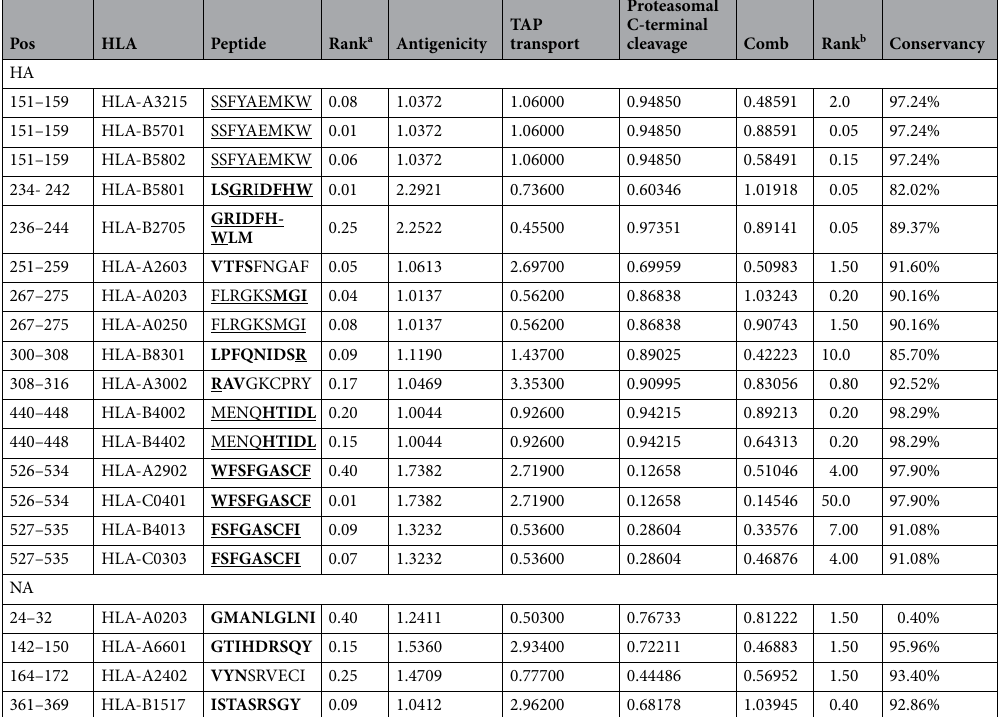
Table 2. CLT epitopes prediction by NetMHC4 server. HA and NA epitopes were selected based on MHC-I HLAs binding affinity (nM), %rank and antigenicity rate. TAP transport/Proteasomal C-terminal cleavage potential selected epitopes were evaluated and degree of conservation was considered for all selected epitopes. Overlapped CLT epitopes are shown in underlined characters as well as CLT epitopes overlapped with HTL epitopes are shown in bold characters. a Rank Threshold for Strong binding peptides is equal to < 0.5 and for Weak binding peptides is equal to < 2.0. b Rank Threshold for epitope identification is equal to <